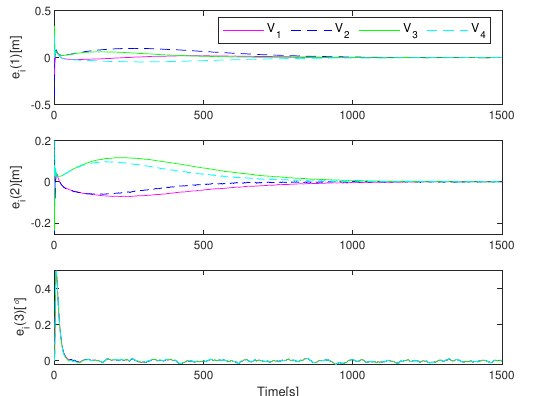
Figure 5. Tracking errors of four vessels using proposed control method. ( V i (i = 1,. . . ,4) denotes the i th